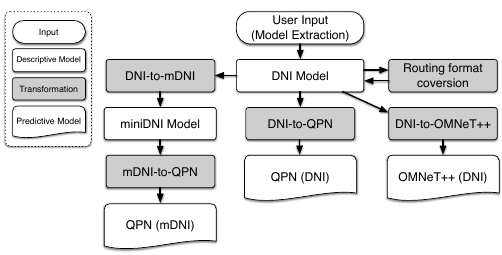
Figure 3: Models and model